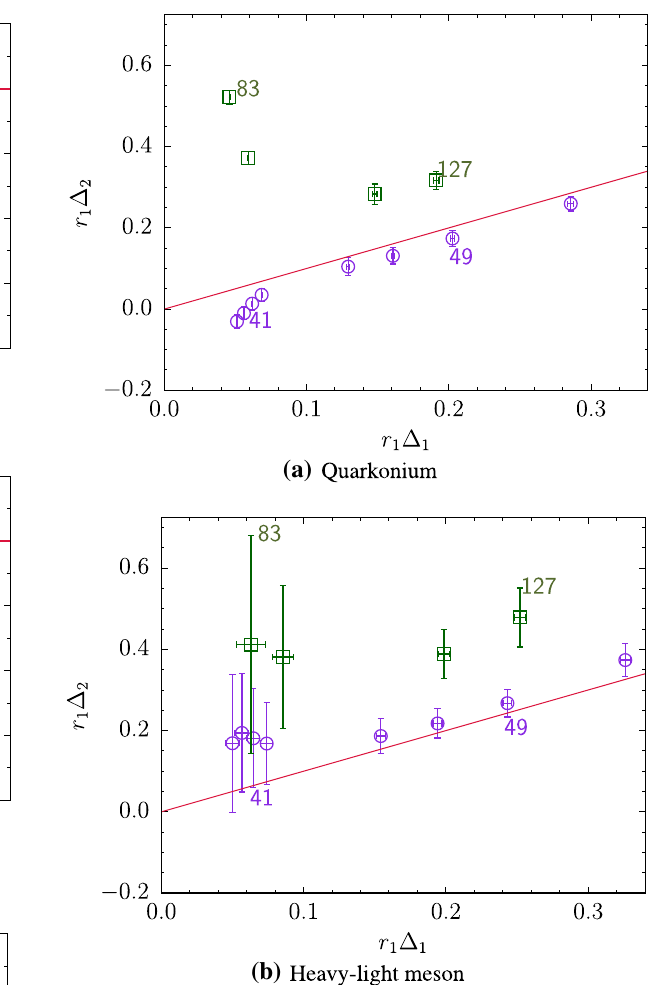
Fig. 5 Hyperfine splitting Δ 2 obtained from the kinetic masses vs. Δ 1 , obtained from the rest masses. The square (green) represents the Fermilab action data, and the circle (purple) represents the OK action data. The labels are κ × 10 3 , corresponding to kinetic masses close to the physical B s (83, 41) and D s (49, 127) masses, as shown in Fig. 4. The continuum limit is represented by the line (red) Δ 2 = Δ 1 . Errors are from the